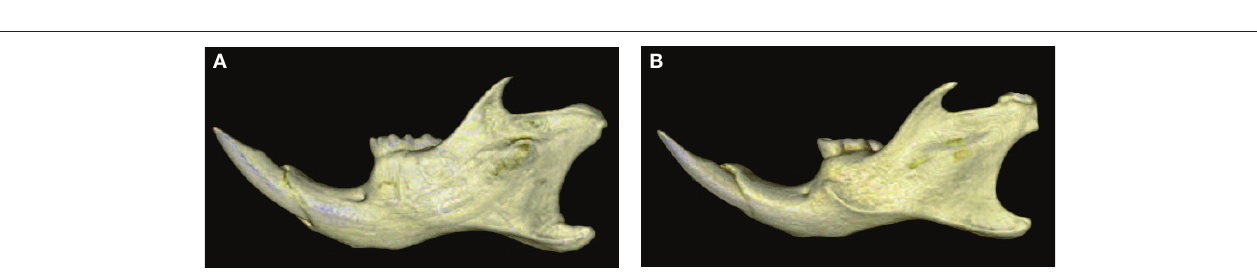
Figure 5 | Subtle shape differences between WT and hemizygous Tabby specimens highlighted by the contribution of the ninth Fourier ellipse. The greater elongation of the ninth ellipse (blue) reflects a more backward projection of the coronoid process in the hemizygous Tabby specimen.